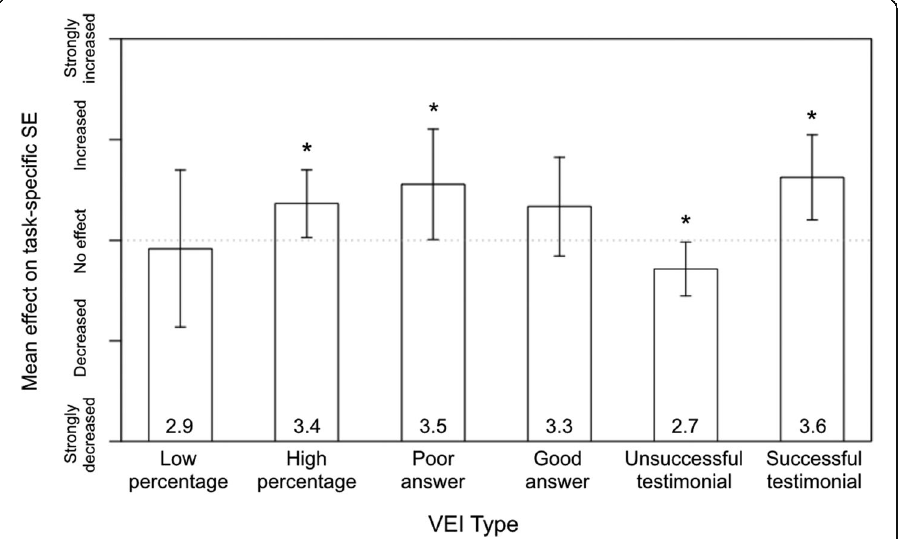
Fig. 9 Mean effect of each VEI type on the task-specific SE of individuals with low general SE. An asterisk (*) indicates a mean significantly different from 3 ( ‘ No effect ‘